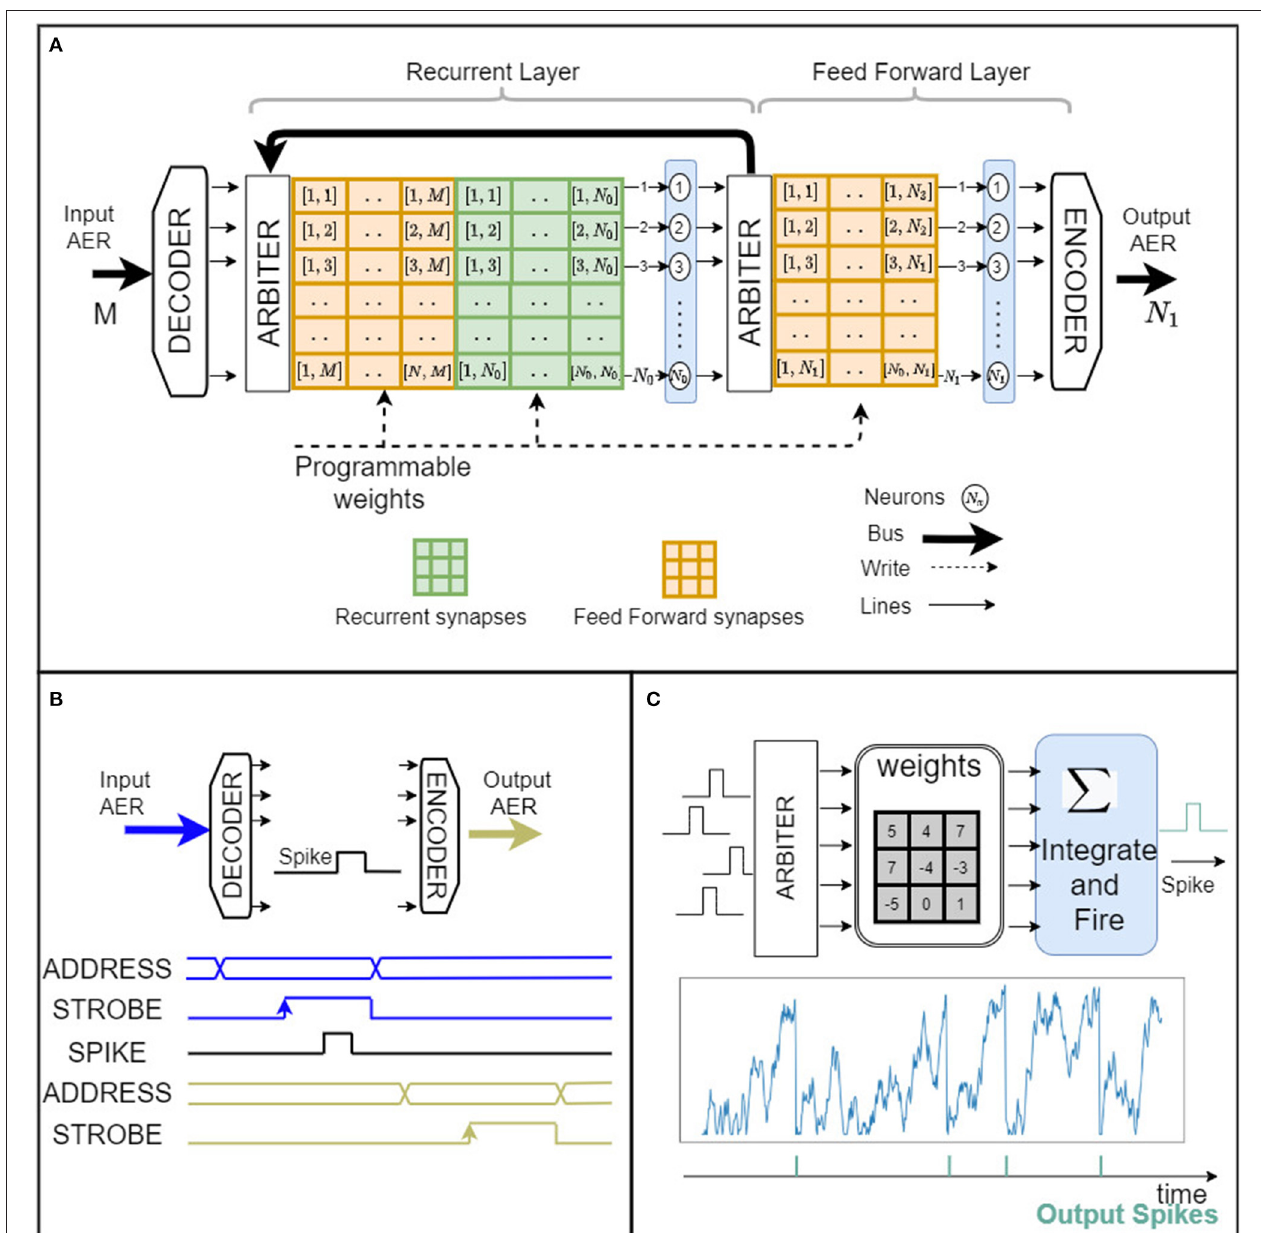
FIGURE 1 | µ Brain event-driven architecture. (A) The digital architecture is organized in layers. Each layer consists of an arbiter, a weight memory matrix for forward and recurrent connections, and a set of IF neurons. The architecture can be synthesized for an arbitrary number of neurons, weight bit width resolution, and synaptic memory size M , N x – where M , is the number of inputs and N x is the number of neurons in layer indexed by x . (B) Input/Output address event representation signals and timing. (C) Simplified schematic of a digital spiking neuron. Input spikes arriving at random times select corresponding weights, which in turn are added (or subtracted) by an accumulator. Each time the accumulator overflows, the neuron’s circuit emits an output spike on the axon output. The graph below shows the time progress of the accumulator value representing the neuron’s membrane potential. Output spikes are shown below the neuron’s membrane